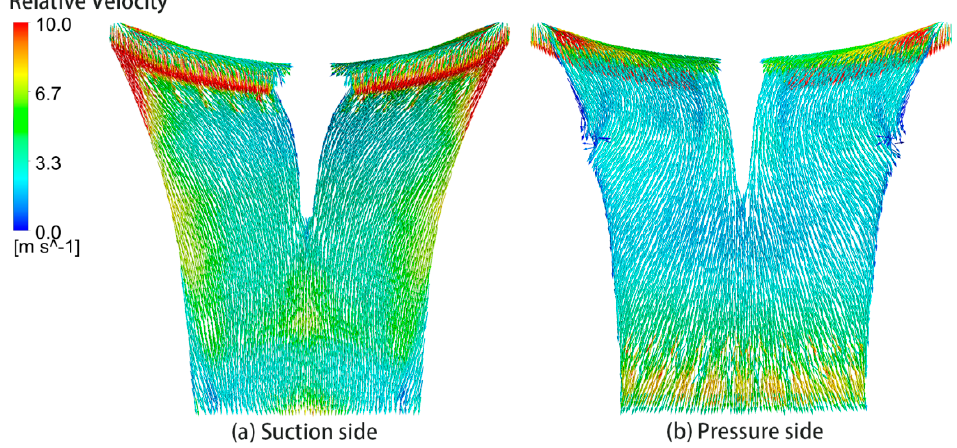
Figure 24. Relative velocity of water around the blade surface with bionic convex domes (units: m/s).